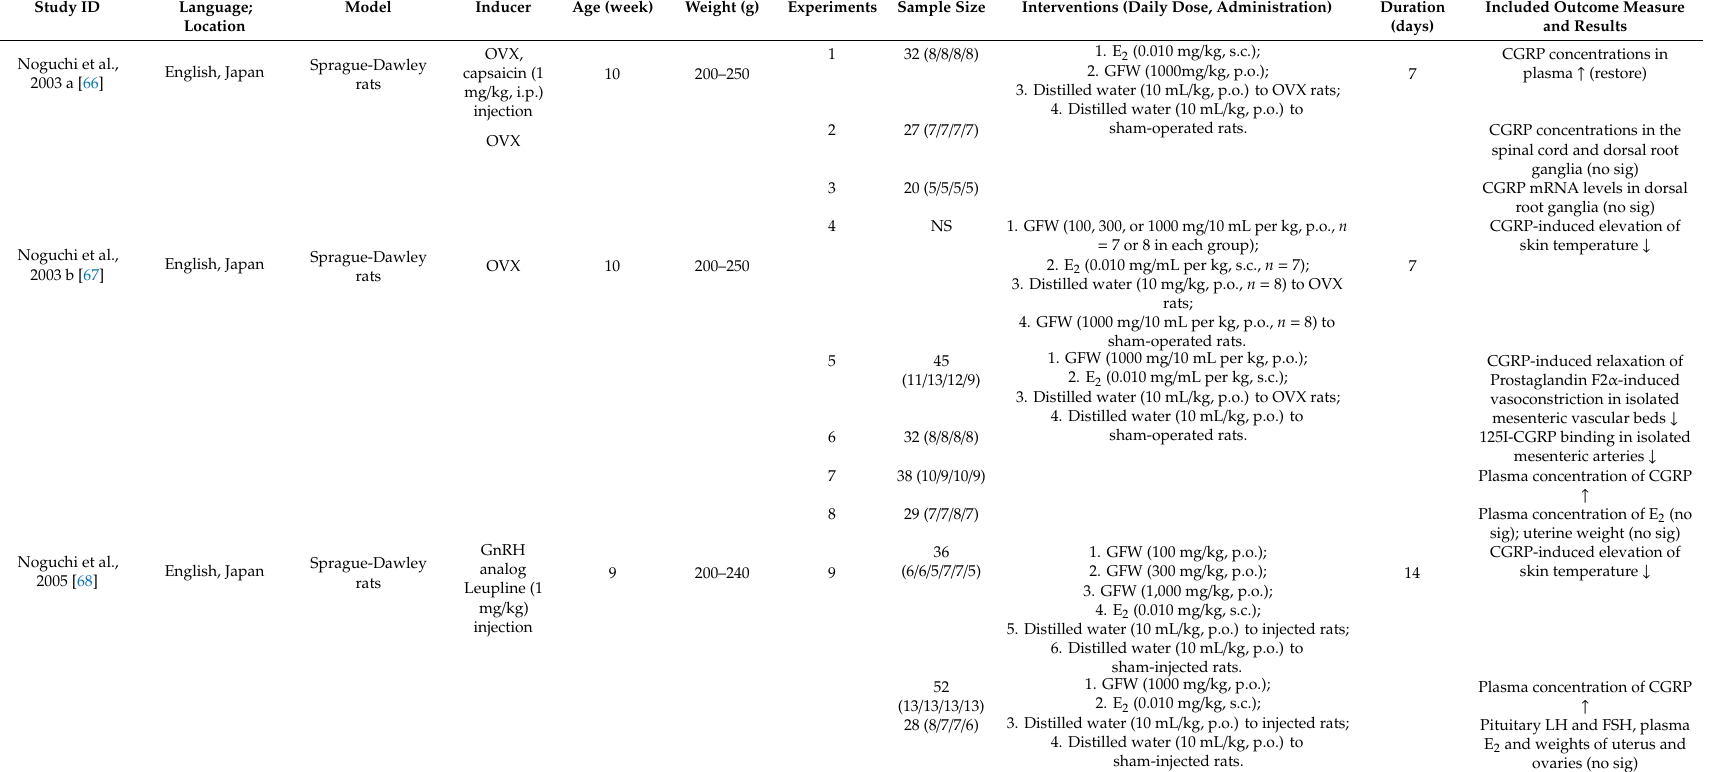
Table 3. Characteristics of in vivo